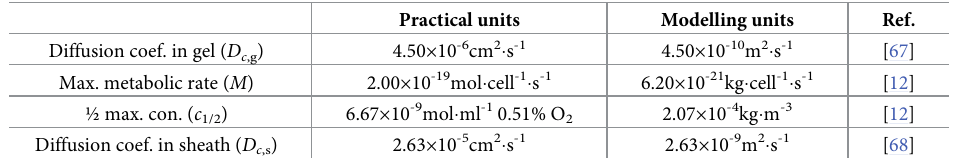
Table 4. Oxygen transport